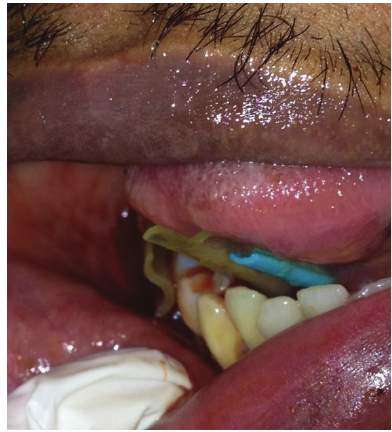
Figure 3: Closeup view of drain in the floor of the mouth “through and through” from submandibular space through the mylohyoid muscle (right drain in picture) and one in submasseteric space (left drain).